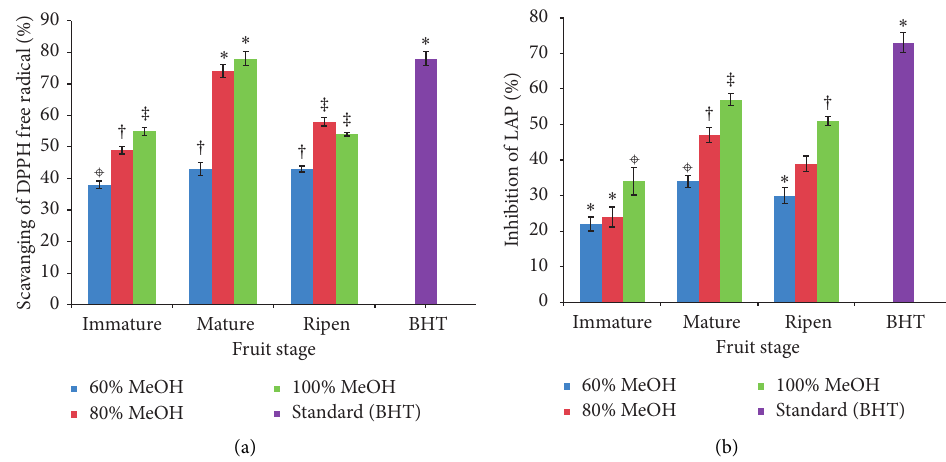
Figure 2: Antioxidant activities of immature, mature, and ripen BG extracts in 60%, 80%, and 100% methanol solvents on DPPH free radicals (a) and linoleic acid peroxidation (b). Each experiment was conducted in triplicate; similar signs show nonsignificant difference while nonsimilar signs show significant difference at level P < 0 .